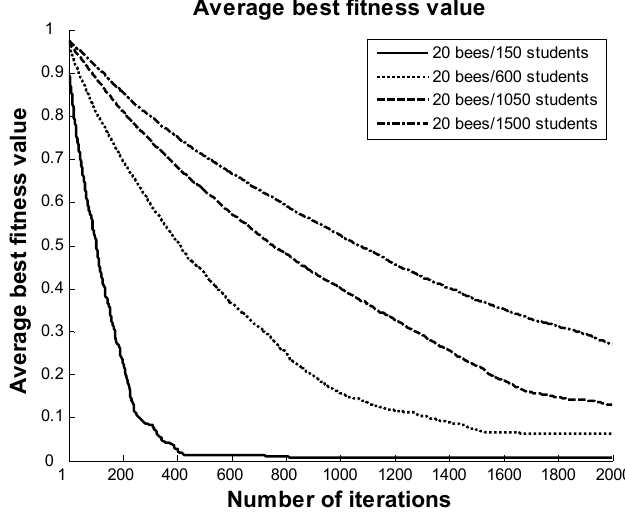
Figure 11. Average execution time values with 20 bees and different numbers of